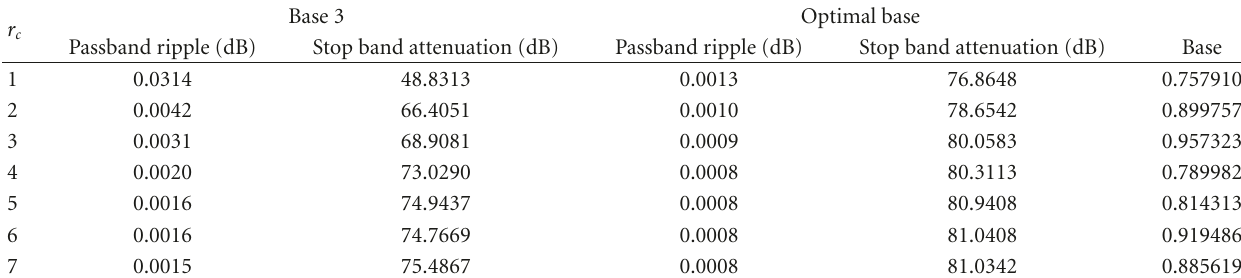
Table 2: Filter performance for ternary and optimal base